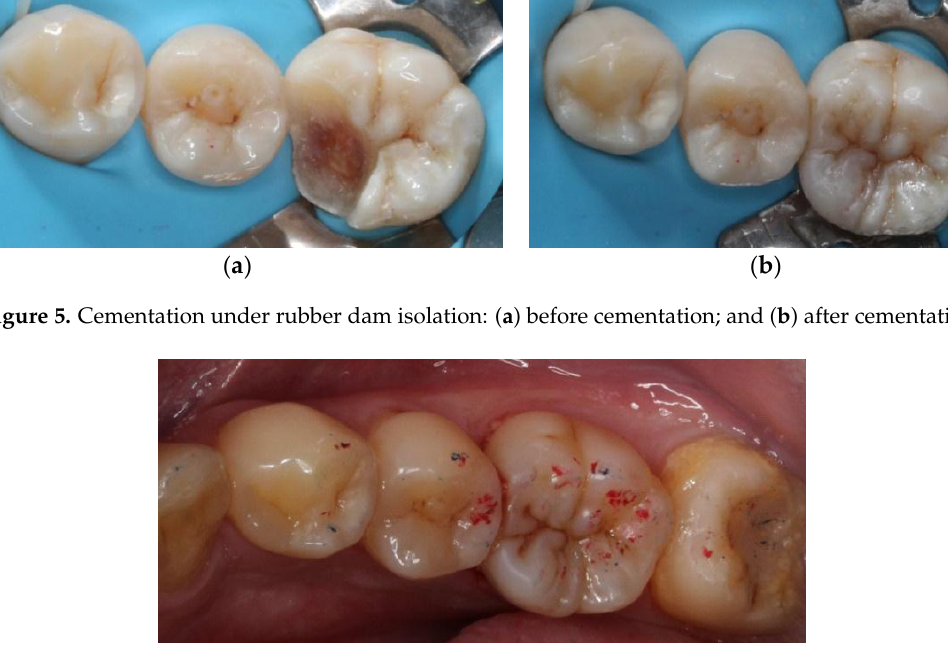
Figure 6. Examining the occlusal contacts after cementation. The blue spots represent the centric occlusion, and the red spots represent the functional movements.